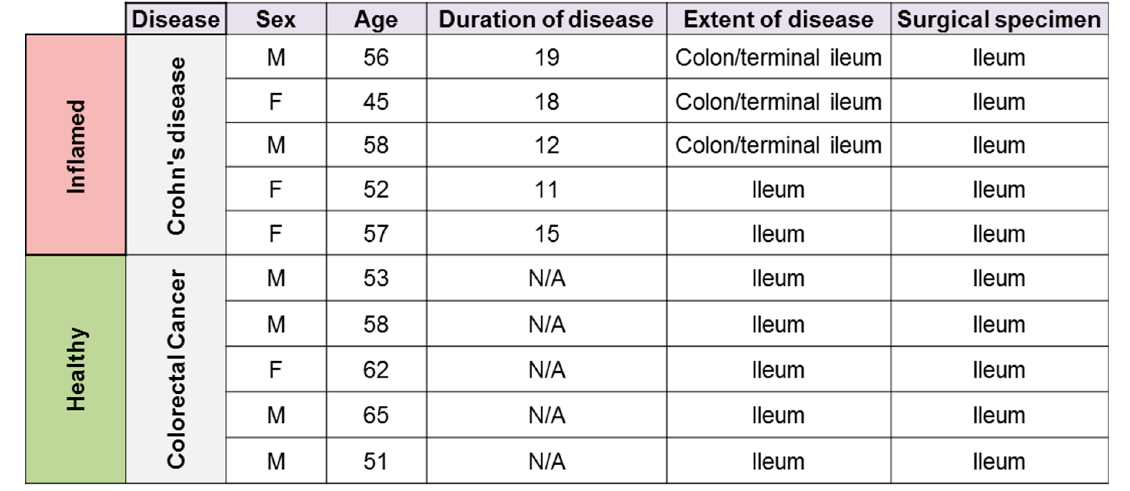
Table 1. Characteristics of enrolled patients with active Crohn’s Disease (CD) and patients with colorectal cancer, whose healthy ilea were used to derive control human intestinal lymphatic endothelial cells (HILECs).